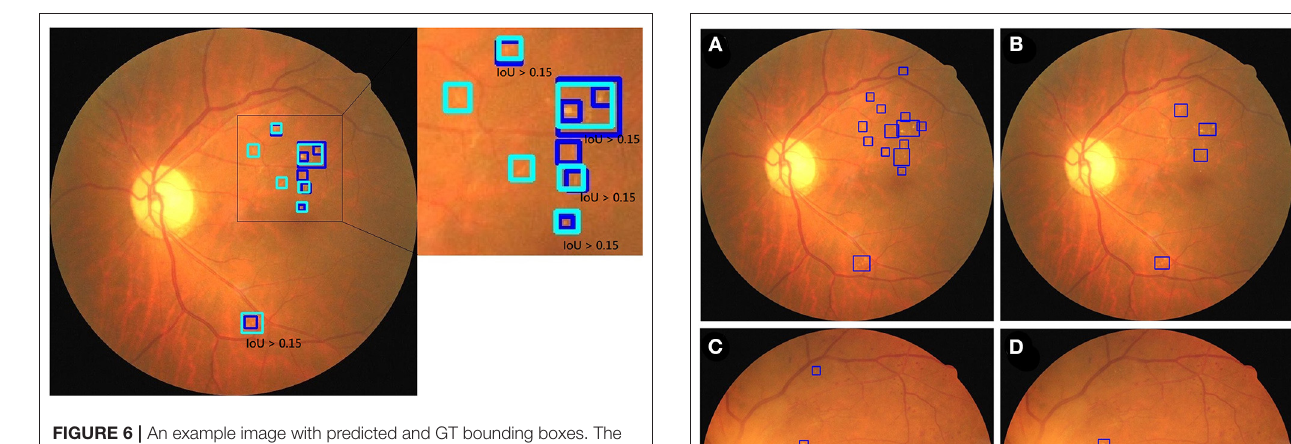
FIGURE 6 | An example image with predicted and GT bounding boxes. The light blue boxes are the prediction result and the dark blue boxes are the GT result. Examples of IoU > 0.15 are marked in image.